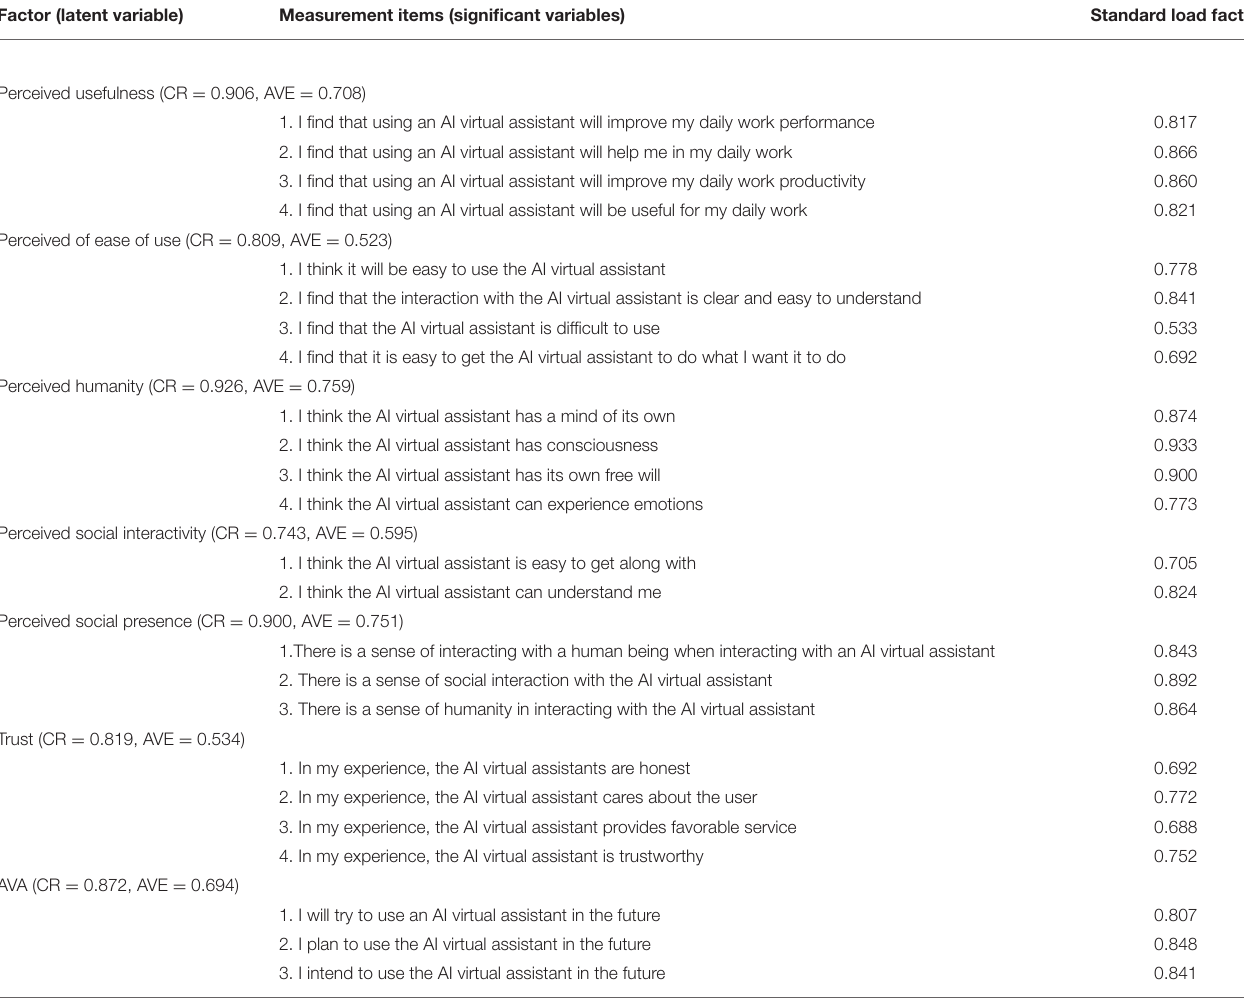
TABLE 4 | Scale items and validity tests.